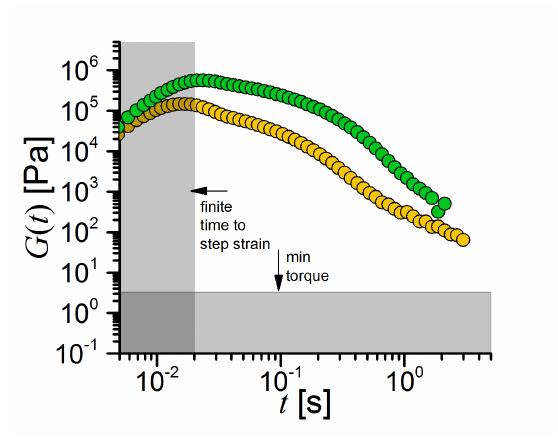
Figure A1: Soft (yellow) and firm (green) putties are subjected to a step-strain at 1 % strain. The stress σ relaxation behavior is normal- ized by the input strain 𝛾 0 and reported as a relaxation modulus G ( t ) . Experimental limits (short time and minimum torque) are shown as shaded regions.